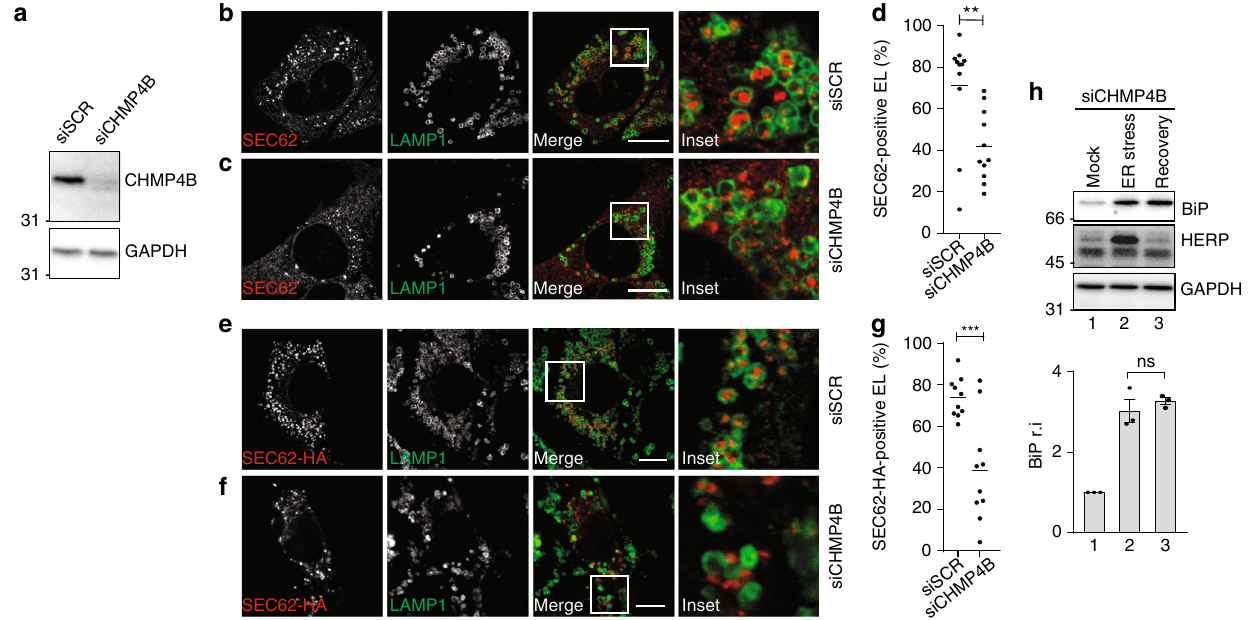
Fig. 5 A role of CHMP4B in recov-ER-phagy. a WB showing knockdown ef fi ciency for siCHMP4B. b Same as Fig. 1b in MEF transfected with a scrambled siRNA. c Same as b in cells transfected with a siRNA silencing CHMP4B expression. d Quanti fi cation of EV delivery within EL in b , c ( n = 11, 11 cells, respectively). Unpaired, two-tailed t test, ** P = 0.0052. e Same as b in cells where recov-ER-phagy is recapitulated on SEC62 overexpression. f Same as c in cells where recov-ER-phagy is recapitulated on SEC62 overexpression. g Quanti fi cation of EV delivery within EL in e , f ( n = 10, 10 cells, respectively). Unpaired t test, ***P = 0.0006. Data are representative of at least two independent experiments. Scale bars: 10 μ m. h Same as Fig. 1a in cells transfected with a siRNA silencing CHMP4B expression. Quanti fi cation of BiP levels in WB, n = 3 independent experiments, mean ± SEM; unpaired, two-tailed t test, P = 0.4776. Molecular weight markers in WB are in kDa; n.s. not signi fi